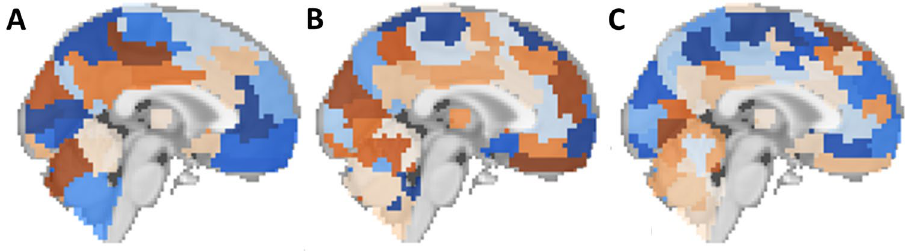
Figure 2. Levels of granularity tested from the BASC atlas. ( A ) Coarse-grained with 64 ROIs, ( B ) medium- grained with 122 ROIs, ( C ) Fine-grained with 197 ROIs 62,64